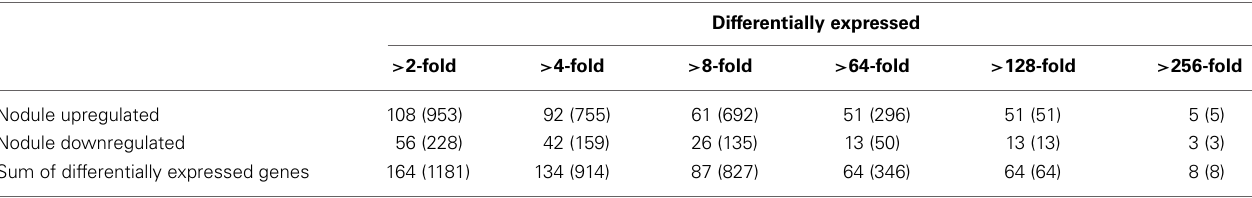
Table 2 | Number of differentially expressed genes in root and nodule tissue from chickpea cultivar Beja